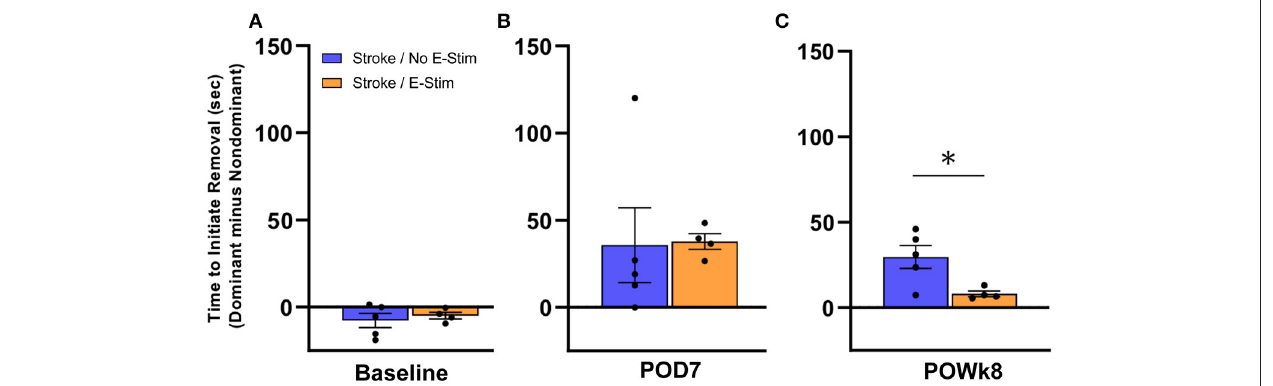
FIGURE 6 | Adhesive removal analysis. Both Stroke/No E-stim and Stroke/E-stim groups showed similar time in the initiation difference between two forelimbs for adhesive removal at pre-stroke baseline (A) and such initiation difference increased greatly at 7 days post-stroke (B) ( p > 0.05). (C) At the end of behavioral tests, i.e., 8 weeks after stroke, animals receiving direct electrical stimulation on median nerve showed significant less time difference between two limbs to initiate adhesive removal (mean ± SEM, Non-parametric Mann-Whitney test, * p <